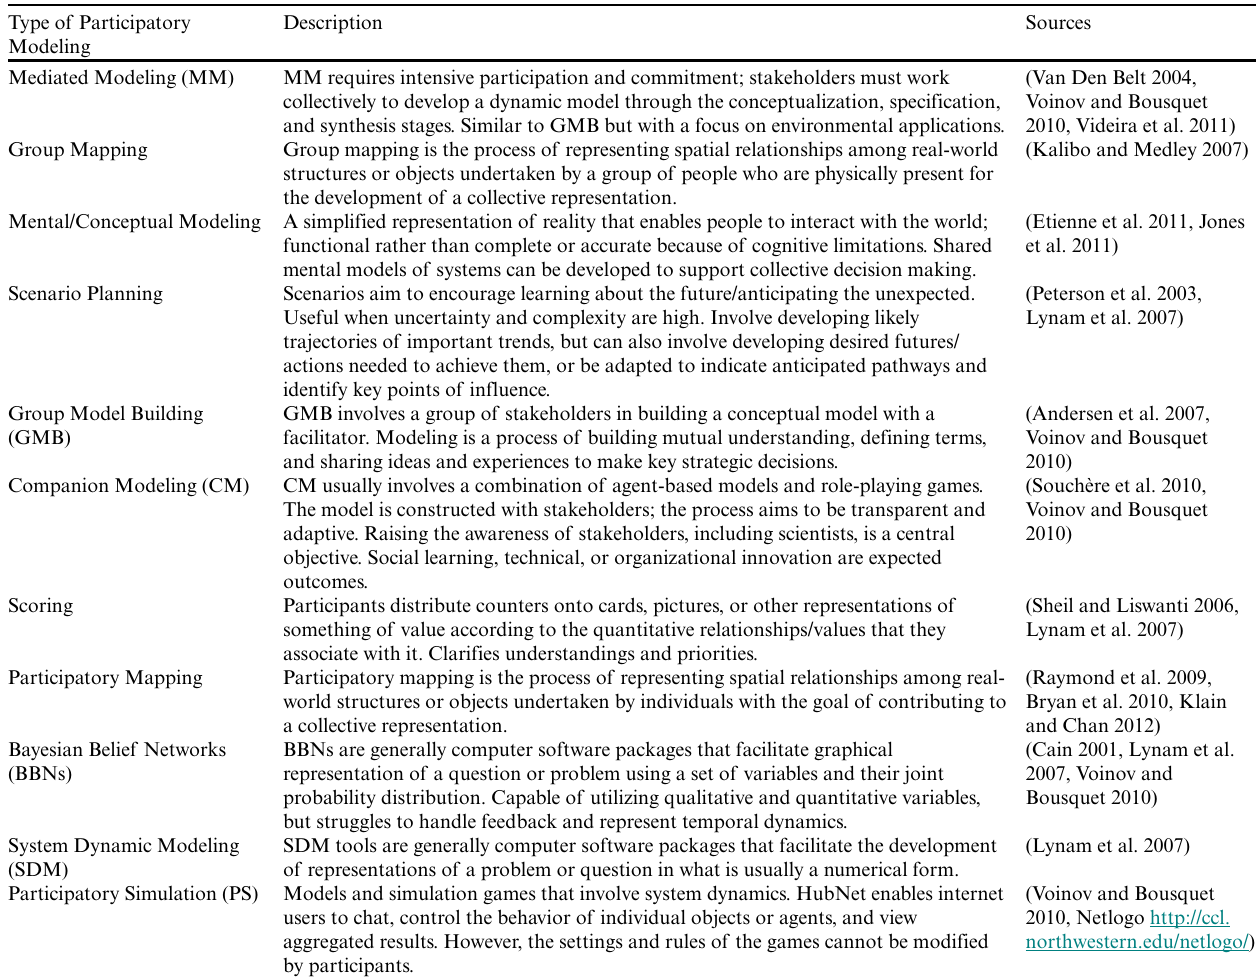
Table 1 . Types of participatory modeling that could be utilized in the development, implementation, and improvement of ecosystem services frameworks which aim to address wicked